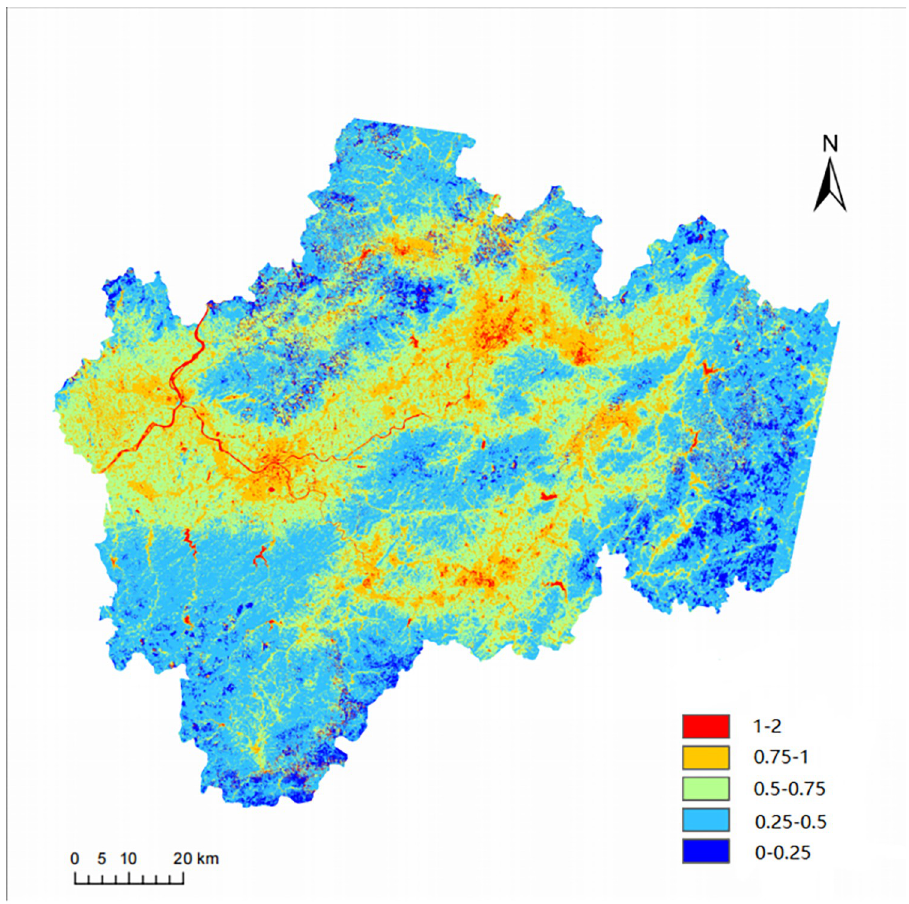
Fig 9. Schematic diagram of coefficient of